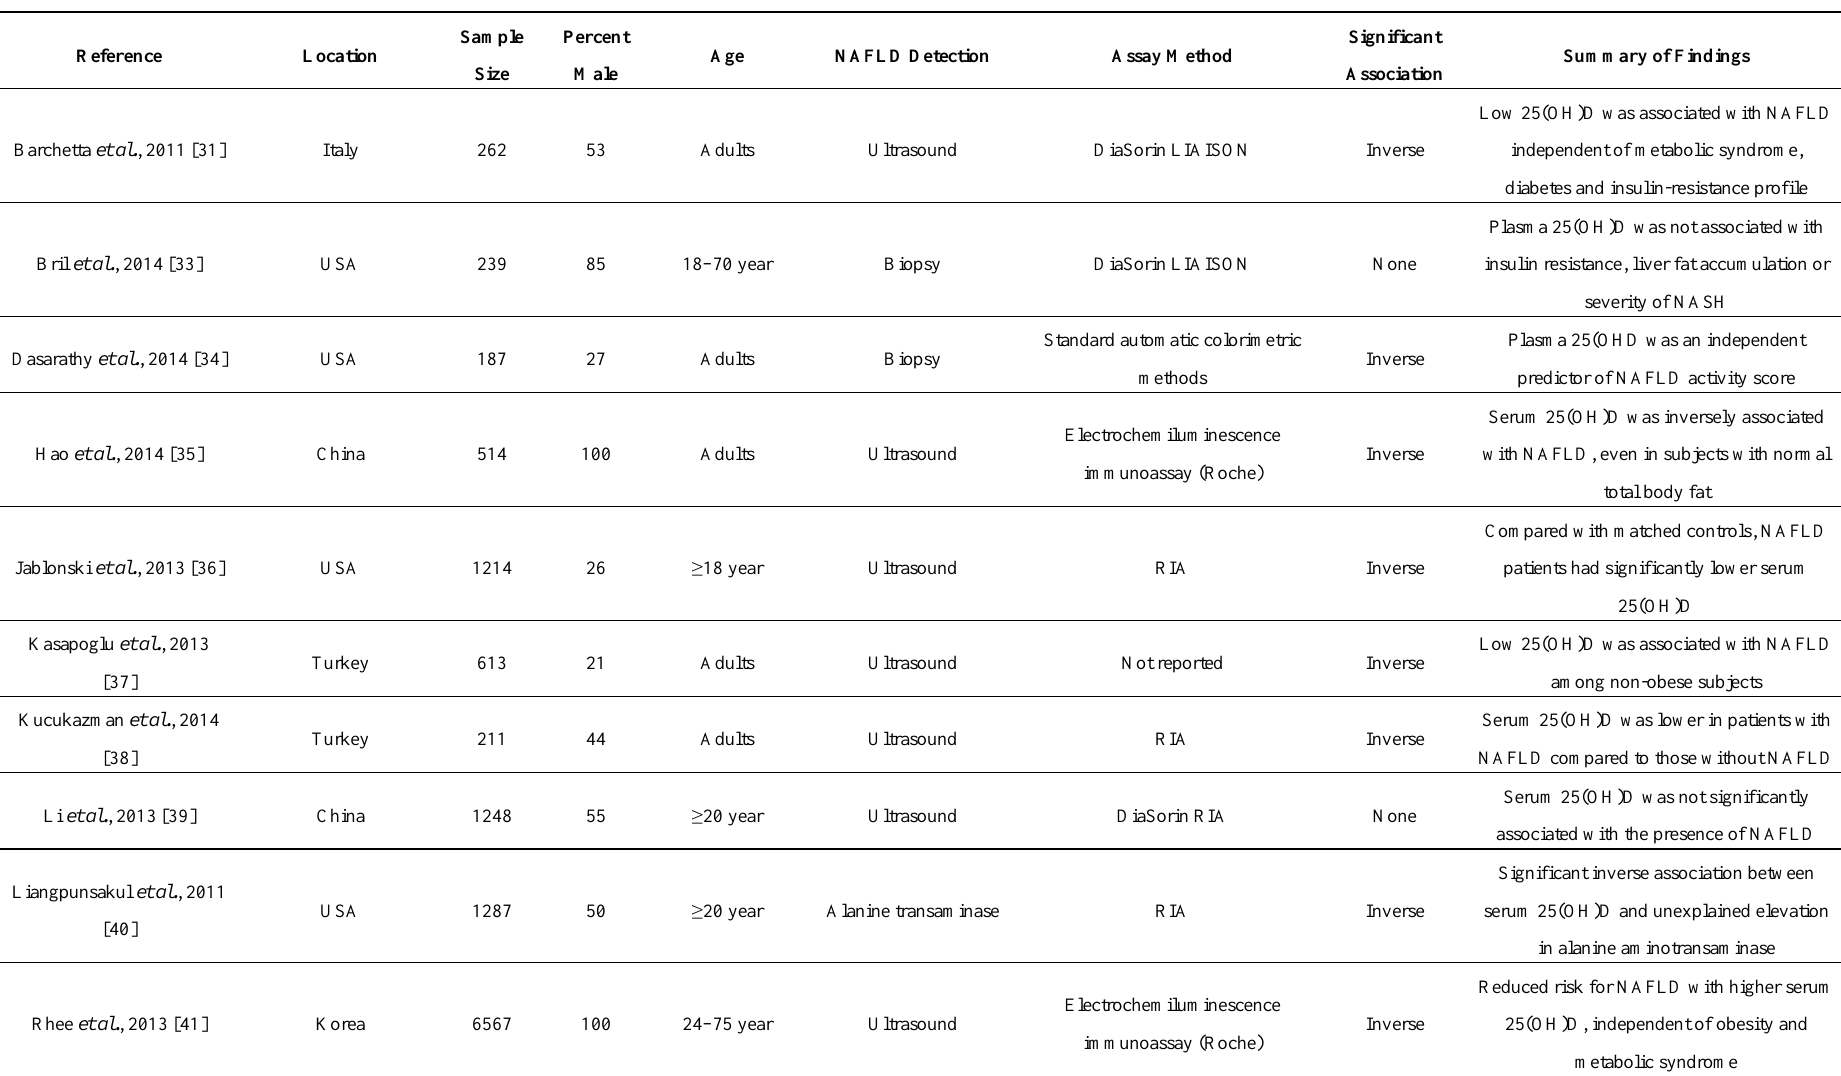
Table 1. Associations of circulating 25(OH)D and